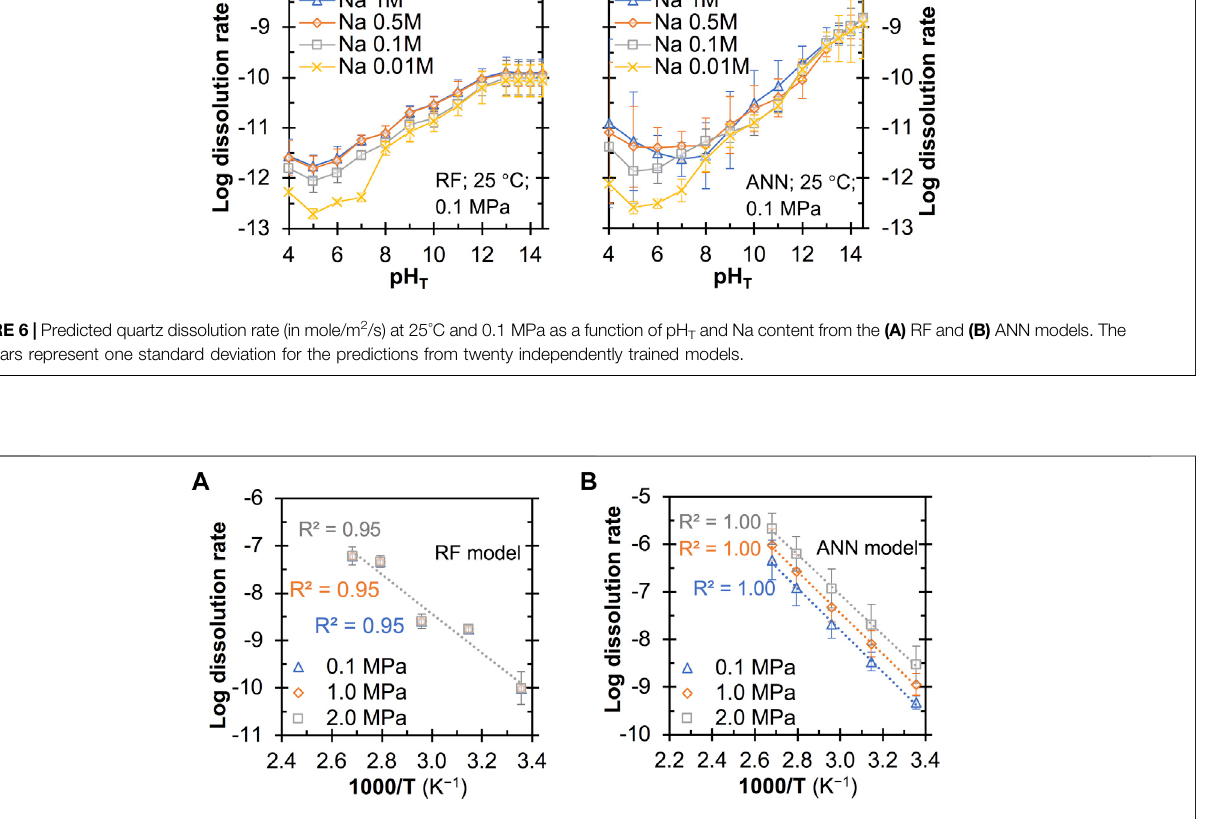
FIGURE7| Predictedquartzdissolutionrate(inmole/m 2 /s)atpH T =13asafunctionoftemperature(i.e.,298,318,338,358and373 (K) andpressurefromthe (A) RF and (B) ANN models. All the predictions are based on a Na + content of 0.1 M and an Al content of zero. The error bars represent one standard deviation for the predictions from twenty independently trained models.